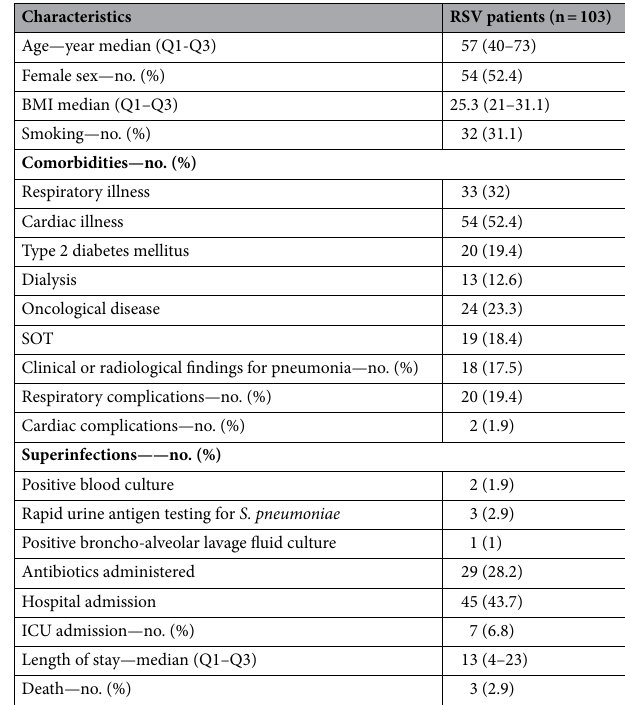
Table 1. Demonstrates the baseline demographics of RSV patients. BMI, body-mass-index; SOT, solid-organ transplantation; ICU, intensive care